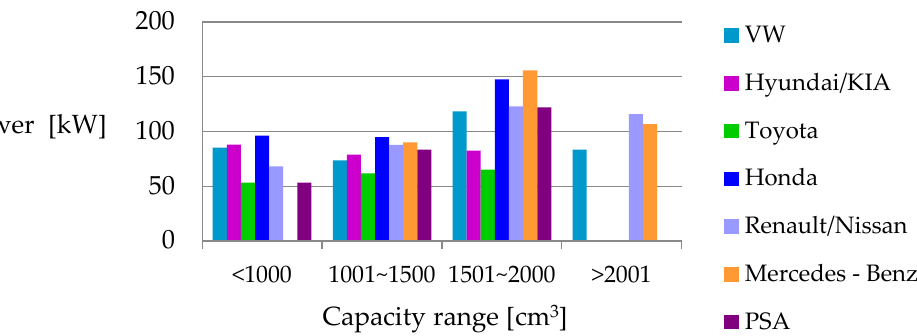
Figure 5. Engine power per liter of displacement in the different engine displacement compartments;